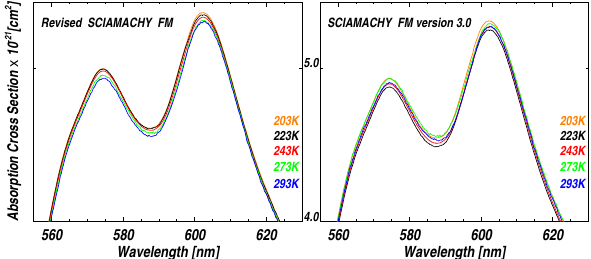
Fig. 7. (Left) Revised temperature-dependent SCIAMACHY FM ozone absorption cross-section spectra in the Chappuis band. (Right) SCIAMACHY FM Version 3.0. The revised spectra pre- serve the correct temperature